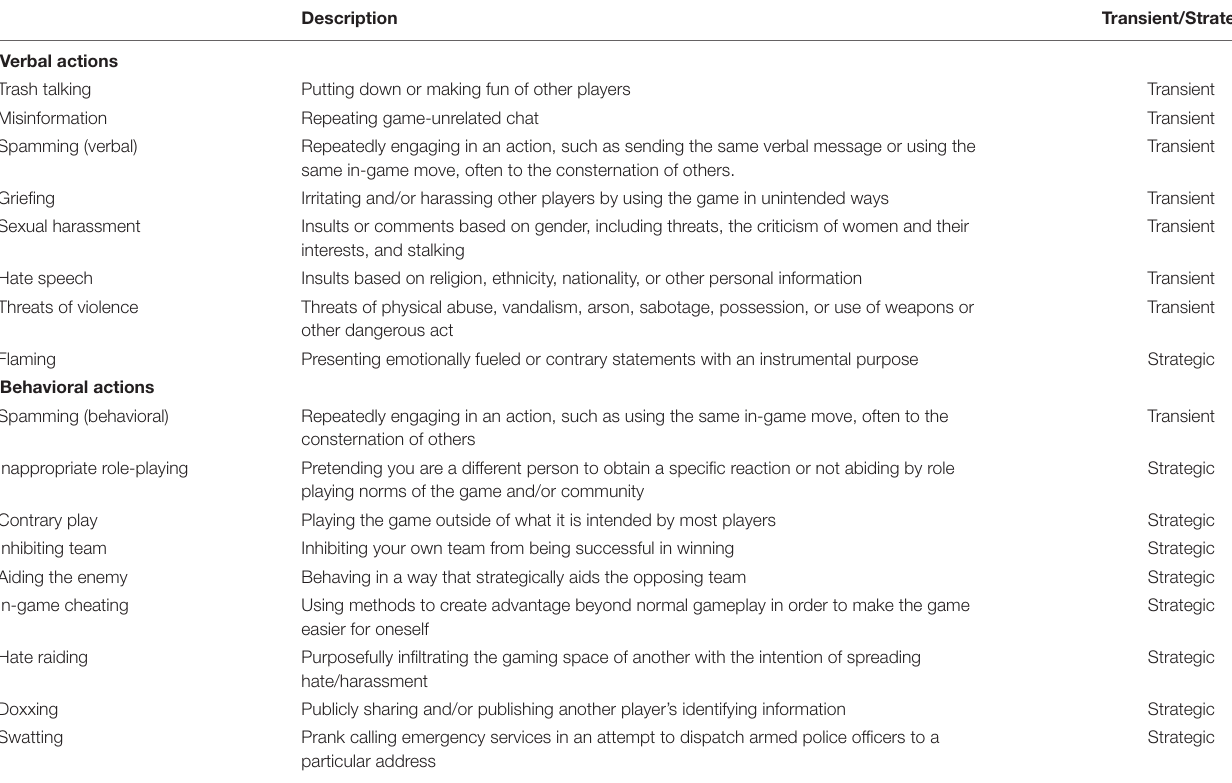
TABLE 1 | Toxic actions in games and gamer culture from verbal/transient to